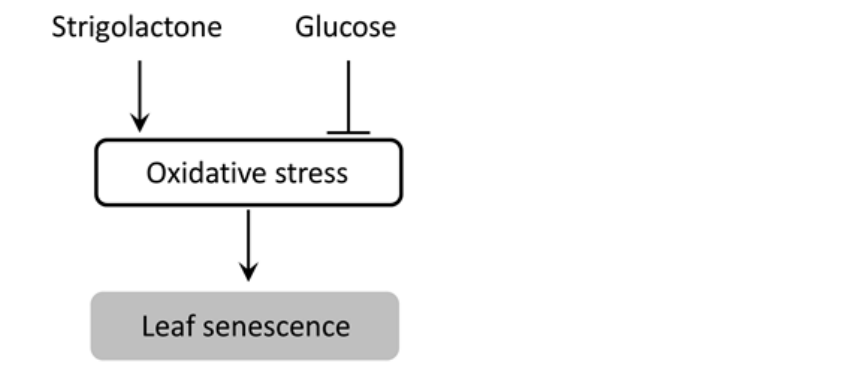
The accumulation of ROS leads to oxidative stress, which causes an increase in the